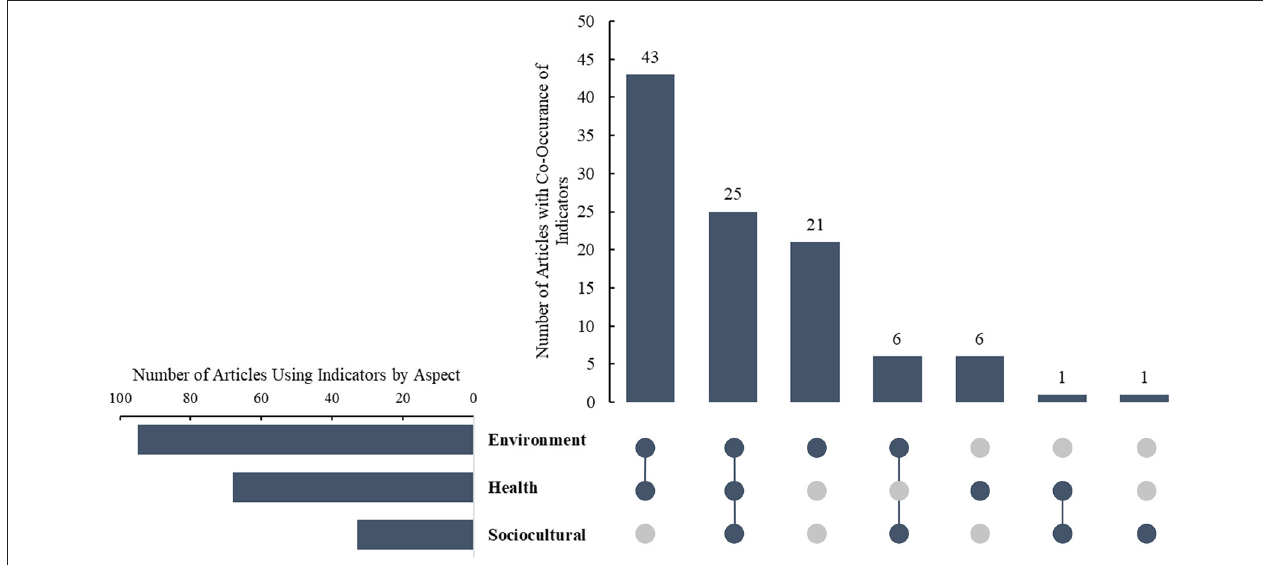
FIGURE 4 | UpSet plot of articles using indicators to assess the sustainability of diets across three aspects. The left bar plot represents the total number of articles using health or nutrition, environmental, sociocultural, or economic indicators. Every possible intersection is represented by the bottom plot, and their occurrence is shown in the top bar